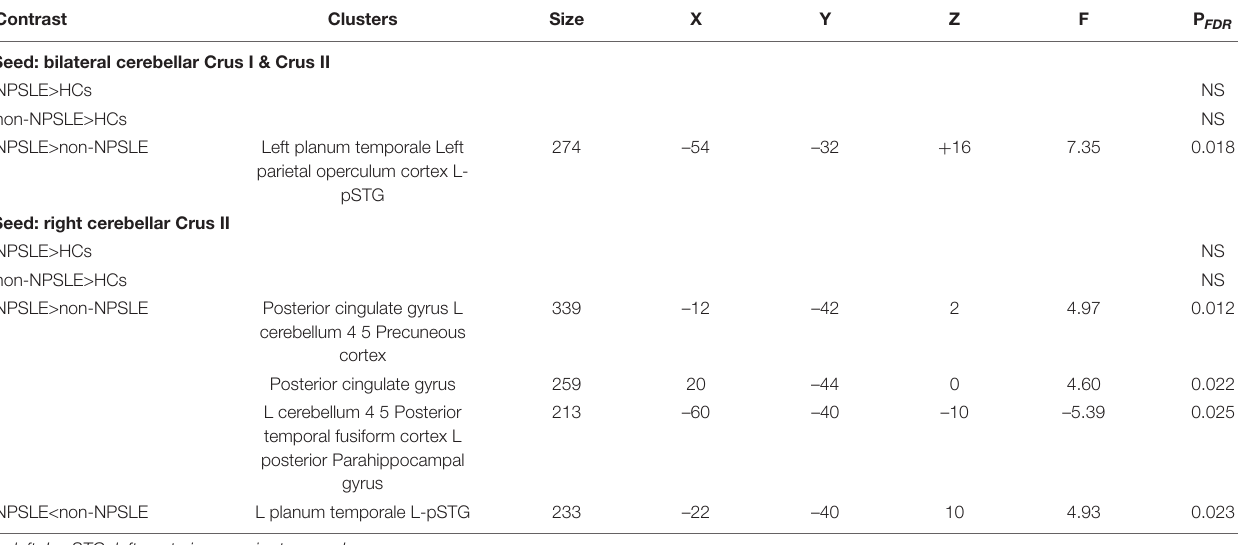
TABLE 3 | Clusters of abnormal RS FC between HC and SLE patients and between subgroups of SLE patients, as the parts of the cerebellar posterior lobes (Crus I, Crus II) being the seeds.